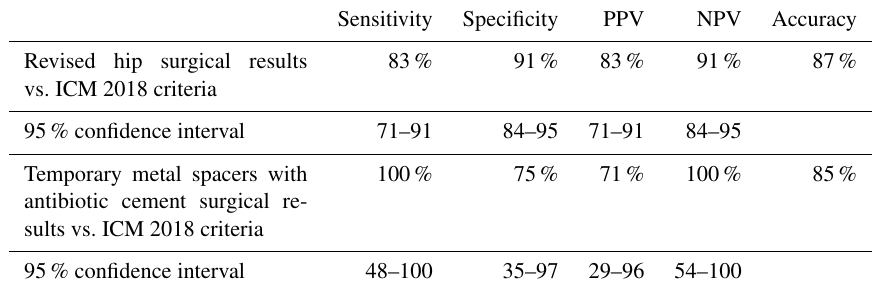
Table 5. Accuracy, sensitivity, specificity, PPV, and NPV of surgical results (infected or not infected) compared with ICM 2018 criteria derived from aspirate results or patient criteria; N = 196.